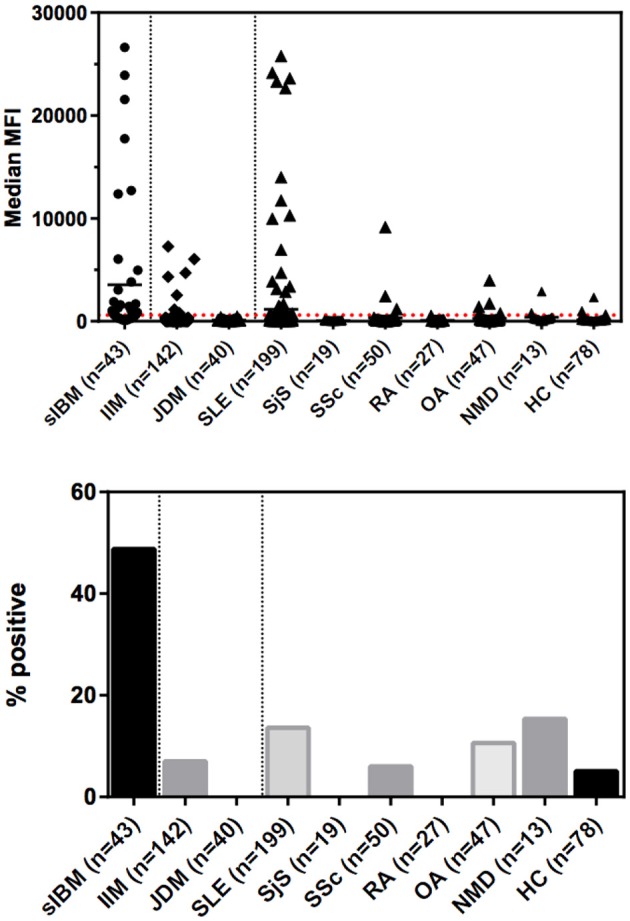
Levels and prevalence of anti-NT5c1a antibodies in sporadic inclusion body myositis (sIBM) and other conditions as detected by an addressable laser bead immunoassay based on full-length human recombinant antigen. The cutoff was established at 600 MFU (2 standard deviations above the mean of healthy controls; see dotted line) which provided a diagnostic sensitivity of 48.8% and a specificity of 91.8%. Horizontal bars indicate the mean values for each group. DM, dermatomyositis; HC, healthy controls; IIM, idiopathic inflammatory myopathies; JDM, juvenile dermatomyositis; MFI, median fluorescence intensity/median fluorescence units; NMD, neurological/metabolic disorders; OA, osteoarthritis; RA, rheumatoid arthritis; sIBM, sporadic inclusion body myositis; SjS, Sjögren's syndrome; SLE, systemic lupus erythematosus; SSc, systemic sclerosis.